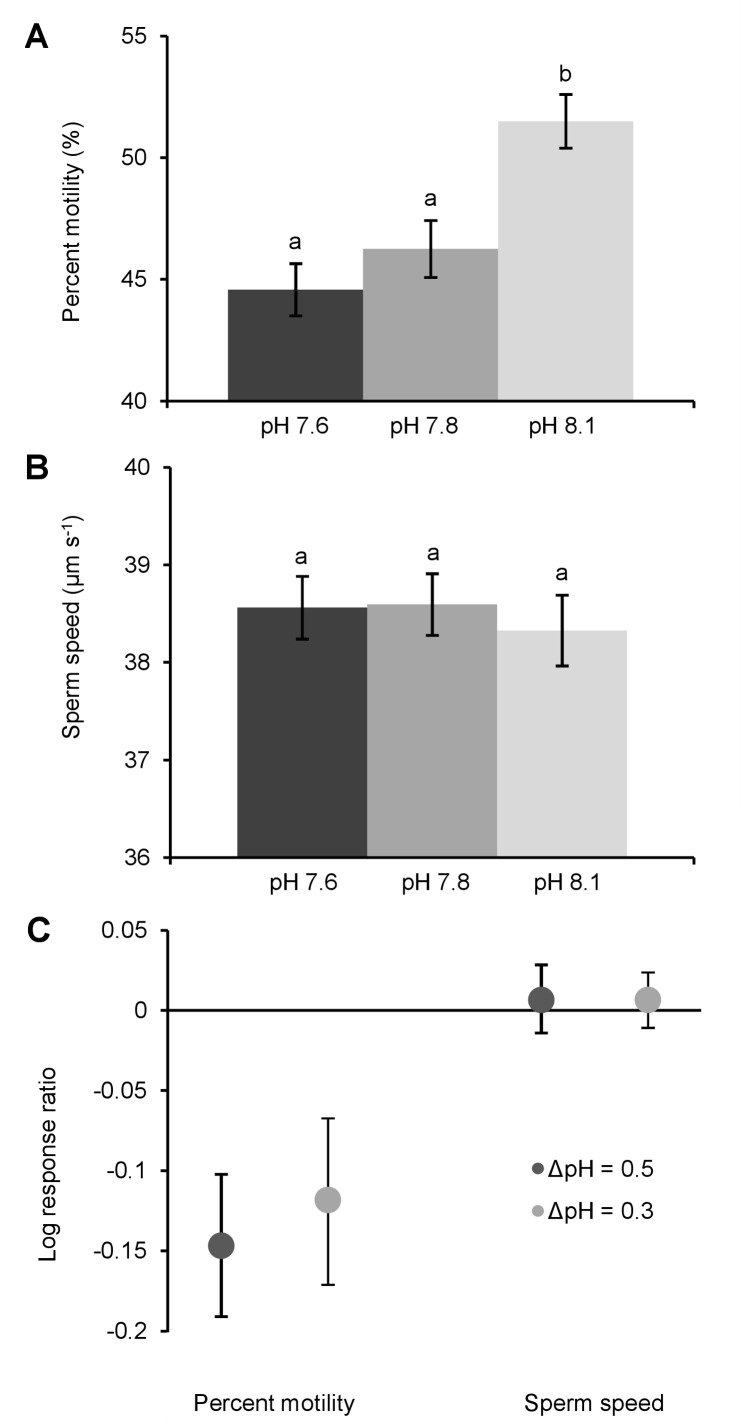
Impacts of ocean acidification on sperm motility and sperm swimming speed in Heliocidaris erythrogramma.
Proportion of mean (±S.E.) motile sperm (A) and sperm speed (B) at different levels of ocean acidification (pH mediated by CO2 addition). Lower case letters indicate significantly different groups at p = 0.05 (Tukey’s test). (C) Mean logarithmic response ratios (±95% CI) of effects of ocean acidification on percent motility and sperm speed (n = 19).